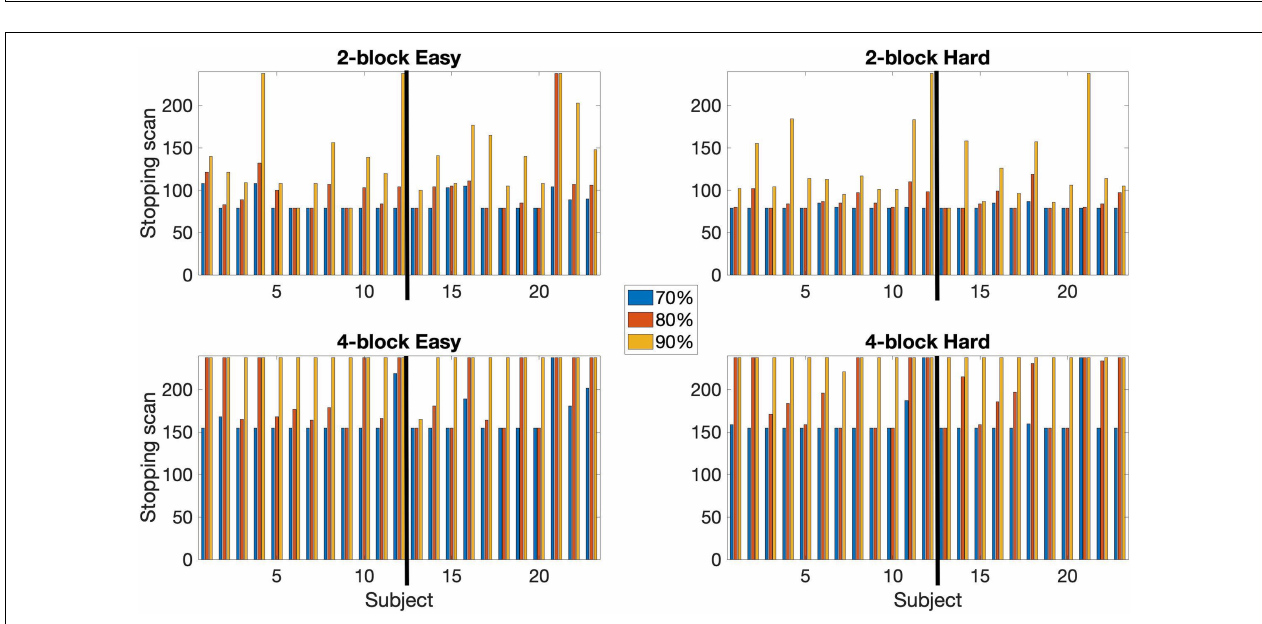
FIGURE 6 | A comparison of the early stopping scans at 70, 80, and 90% of voxels classified as either active or non-active. Conducted using α E = 0.001, β E = 0.1. Both 2-block (top row) and 4-block (bottom row) first stage conditions are presented. The thick black line in each chart indicates the subject groups. Left of the black line (1–12) = control subjects, right of the black line (13–23) = EPT